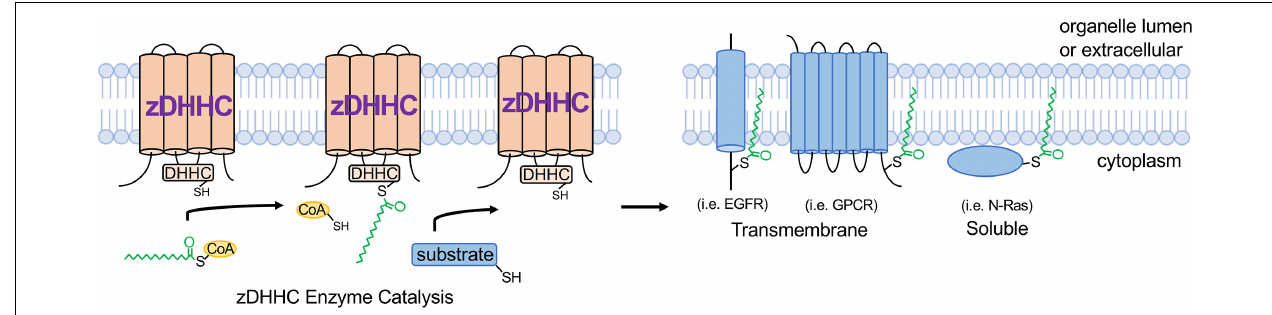
FIGURE 1 | zDHHC S-acyltransferase-mediated substrate modification. zDHHC enzymes modify substrates through a “ping-pong” kinetic mechanism (Jennings and Linder, 2012) whereby the enzyme transiently accepts an acyl chain on its DHHC Cys from acyl-CoA and then transfers the acyl group onto the substrate Cys residue. zDHHCs are transmembrane proteins with their enzymatic DHHC motif on the cytoplasmic loop and substrates are S-acylated on cytoplasmic juxtamembrane or membrane-associated Cys residues. GPCR , G-protein-coupled receptor; EGFR , epidermal growth factor receptor; CoA , coenzyme